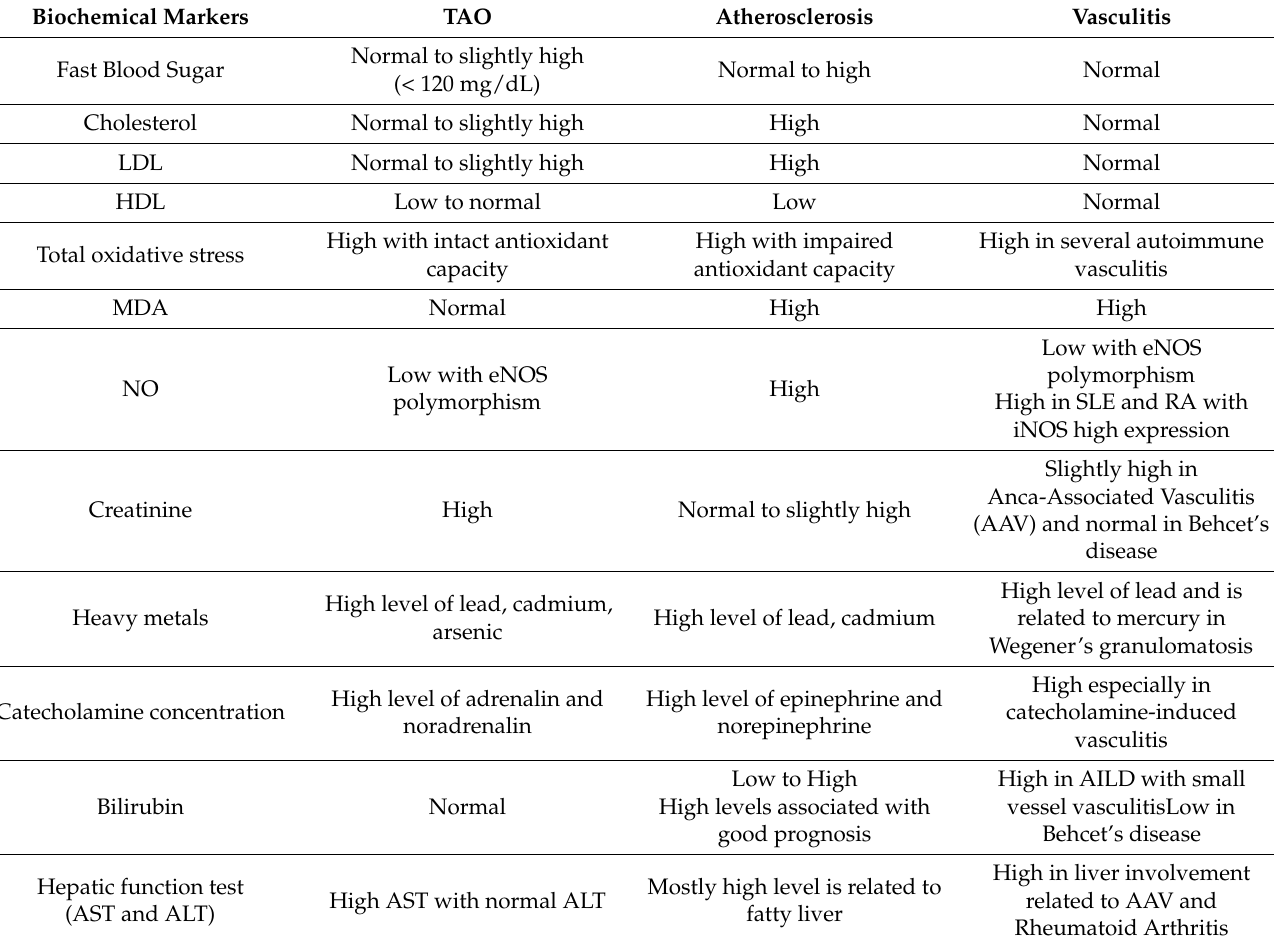
Table 2. Summary of the main findings on biochemical